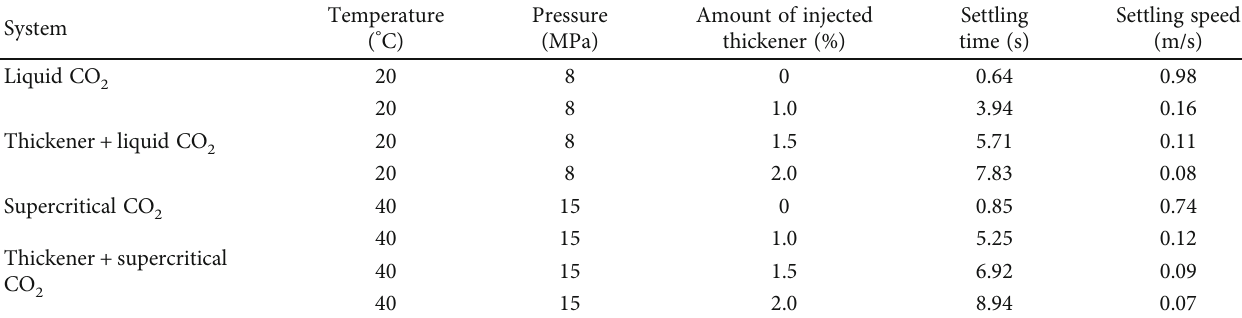
fracturing fl uids. 2